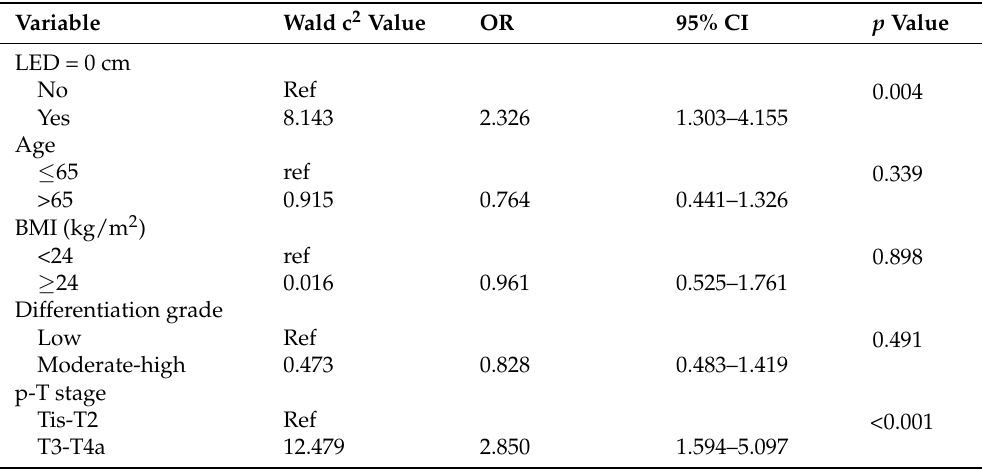
Table 5. Multivariate logistic regression analysis of abdominal LNM in lower